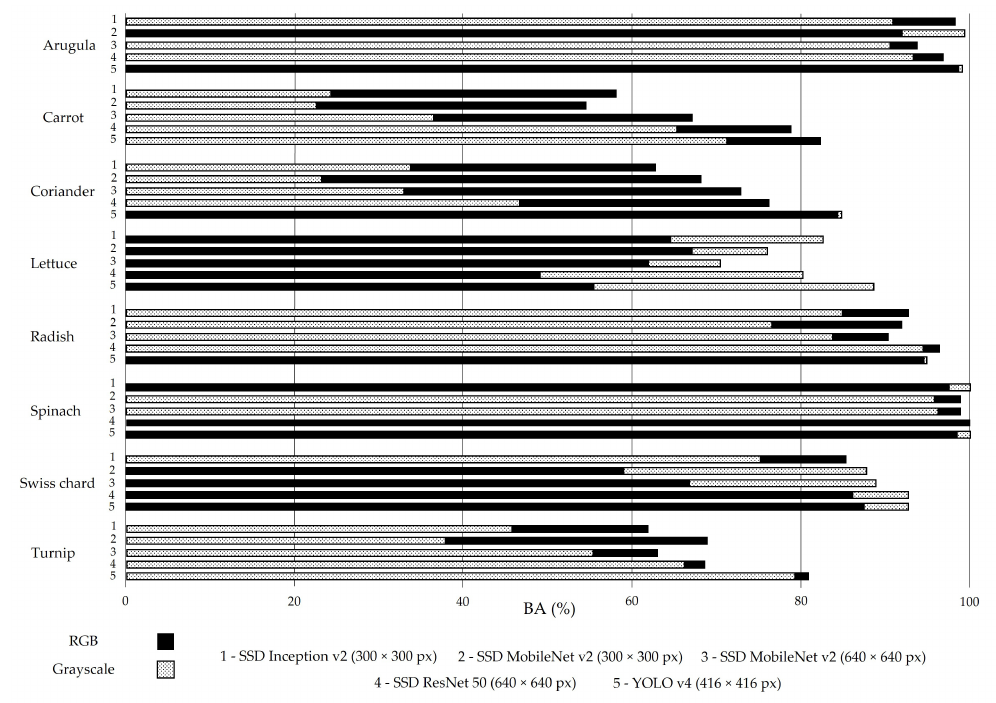
Figure 7. Balanced accuracy (BA) for all models trained with RGB (solid black bars) and greyscale (dashed bars) images in the test set without